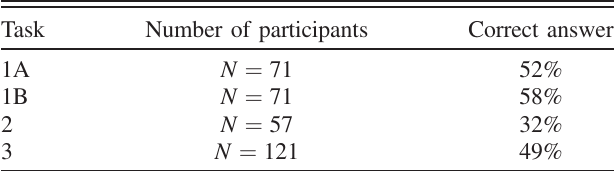
TABLE I. Percentage of correct answer to each question on the written tasks.